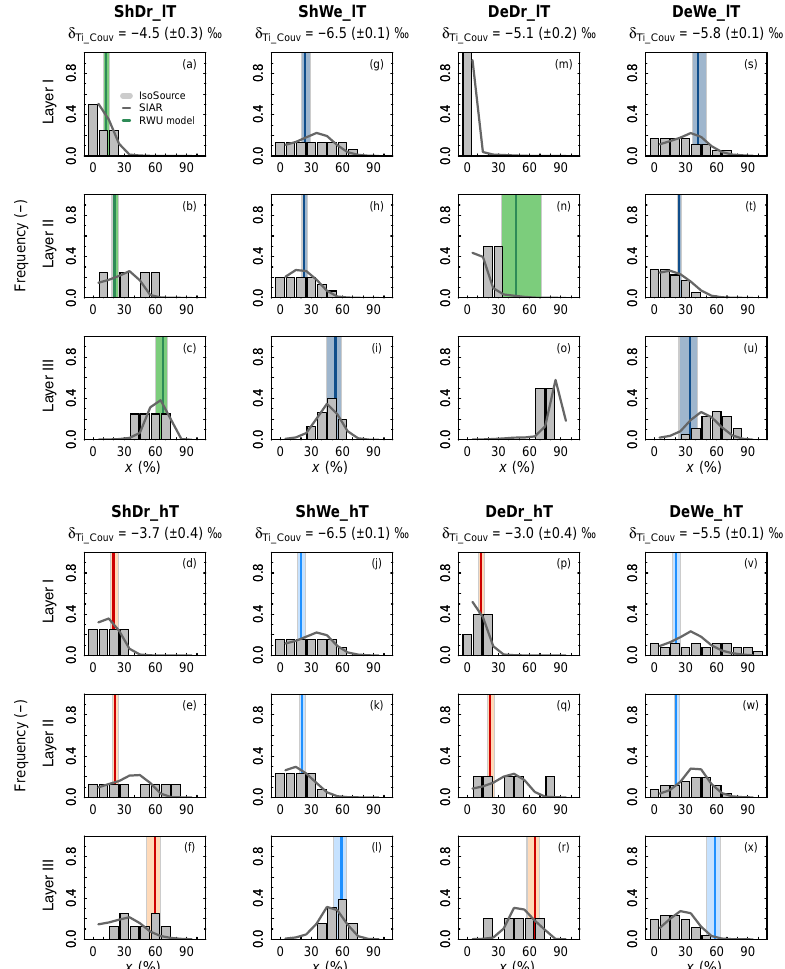
Figure 7. Simulated ranges of possible relative contributions to transpiration from three defined soil layers (I: 0.00–0.05m; II: 0.050– 0.225m; and III: 0.225–2.000) provided by the IsoSource multi-source mixing model (Phillips and Gregg, 2003) (displayed in the form of gray histograms). Density distribution functions following the SIAR Bayesian model (Parnell et al., 2010) (gray lines). “Sh” (“De”) stands for the virtual experiments where the soil has a shallow (deep) groundwater table, while “Dr” and “We” stand for when the soil is dry or wet at the surface. Suffices “lT” and “hT” refer to “low” and “high” transpiration rate simulations. The colored vertical lines give x I_Couv , x II_Couv , and x III_Couv , the relative contributions to transpiration from layers I, II, and III simulated by the analytical model of Couvreur et al. (2012). The color-shaded areas associated with x I_Couv , x II_Couv , and x III_Couv refer to their uncertainty associated with input data